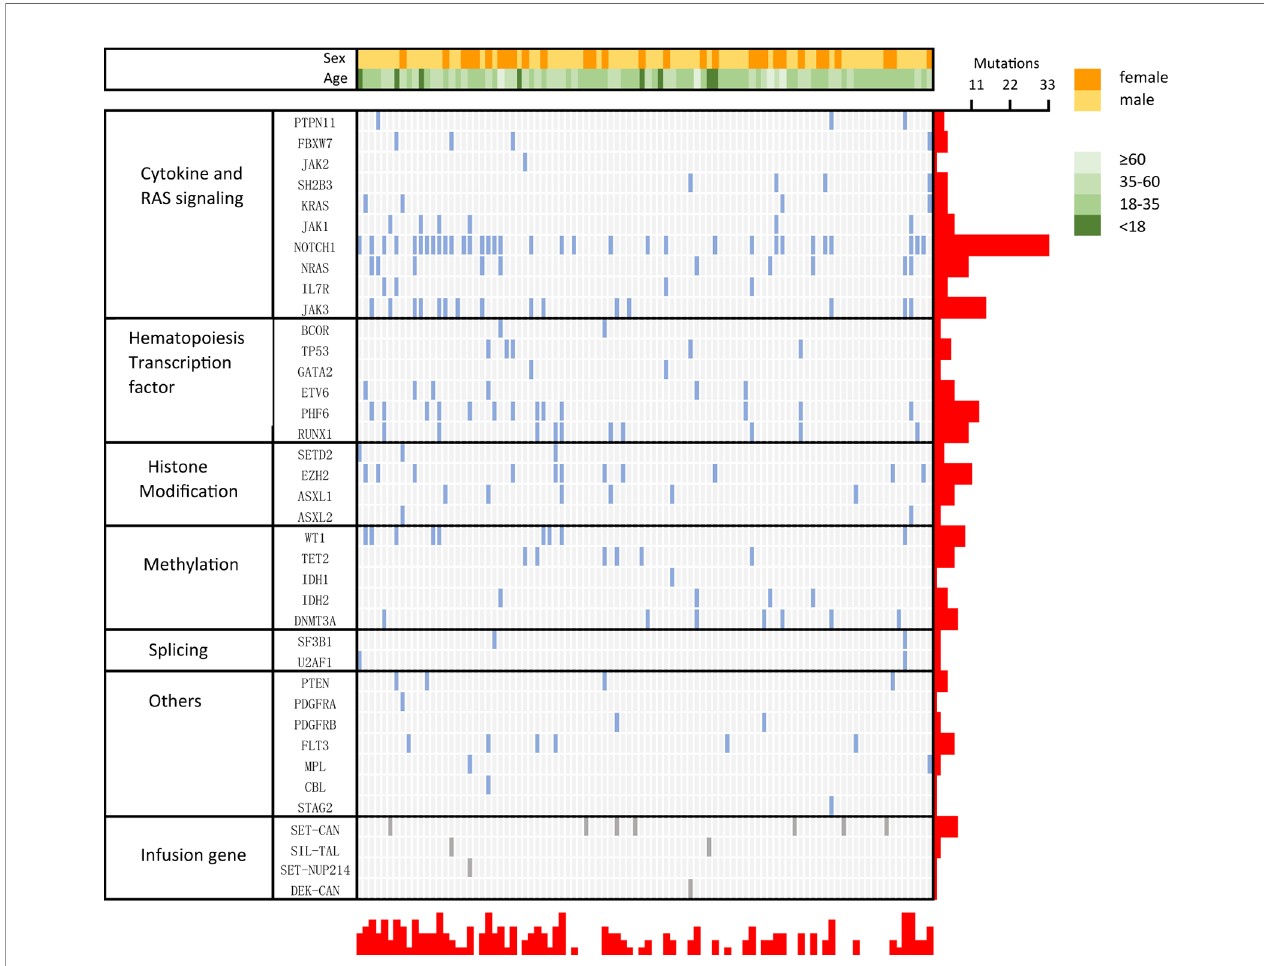
FIGURE 3 | Genetic pro fi le of early T-cell precursor acute lymphoblastic leukemia/lymphoma (ETP-ALL/LBL). Distribution of acquired mutations in 94 patients of